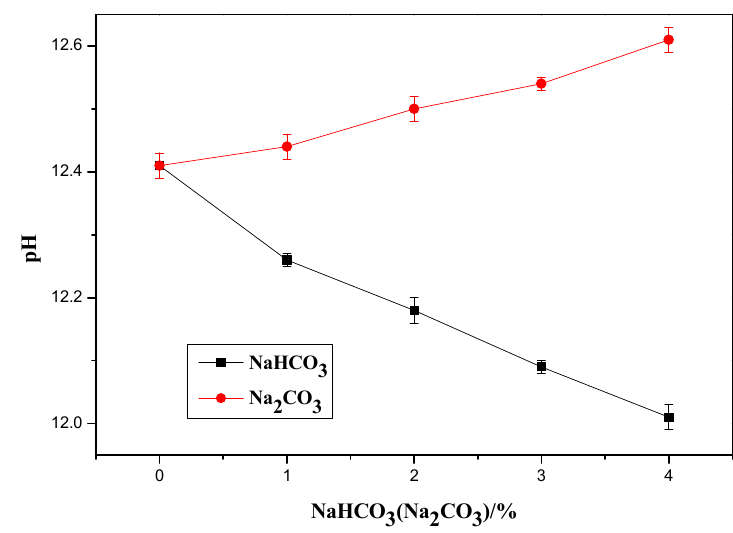
Figure 11. pH of fresh cement paste with Na 2 CO 3 or NaHCO 3 .